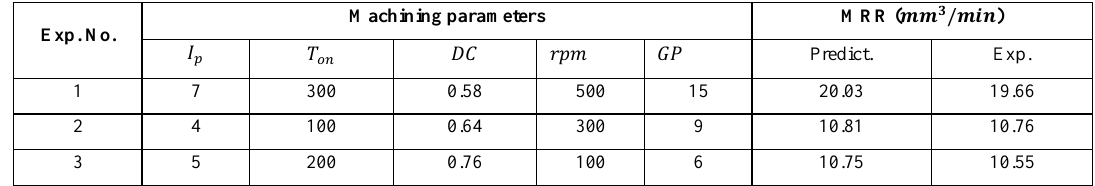
Table 7. Affirmation of the MRR prediction through the proposed